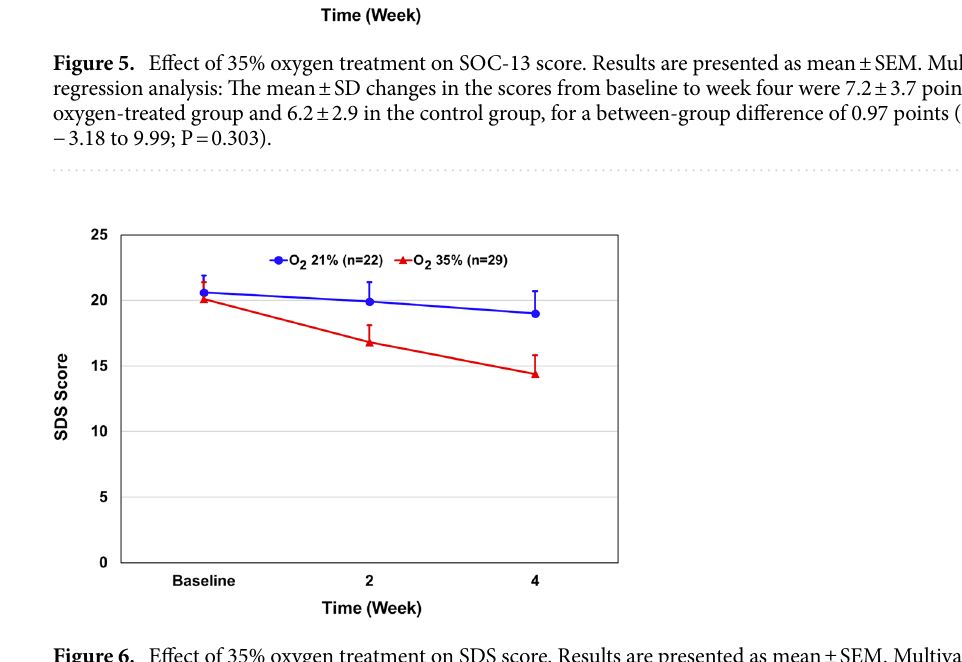
Figure 6. Effect of 35% oxygen treatment on SDS score. Results are presented as mean ± SEM. Multivariate regression analysis: The mean ± SD changes in the scores from baseline to week four were − 5.7 ± 0.6 points in the oxygen-treated group and 1.6 ± 2.2 in the control group, for a between-group difference of 4.1 points (95% CI − 9.84 to 0.22; P =